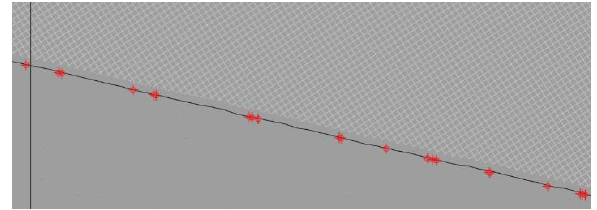
Figure16: Deviation of the points of the horizontal section from the extracted horizontal edge